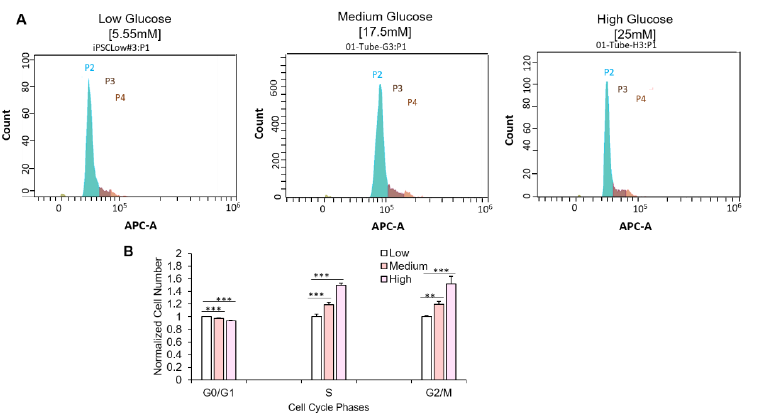
Figure 4. Effect of hyperglycemia on cell cycle progression. ( A ) Pictograph showing iPSC-derived -myoblast distribution among the various cell cycle phases in each glucose concentration (P2, green: G0/G1 phase; P3, dark brown, S phase; P4, light brown, G2/M phase). ( B ) Quantification of iPSC- myoblasts at the various phases of cell cycle in 5.55 mM, 17.5 mM and 25 mM D-glucose conditions. Data was normalized to the cell count of each phase at euglycemic condition. Error bars = SEM. P ≤ 0.1, *; P ≤ 0.05, **; P ≤ 0.01, ***. n = 10. Statistics was performed utilizing One-way ANOVA with post-hoc Tukey HSD